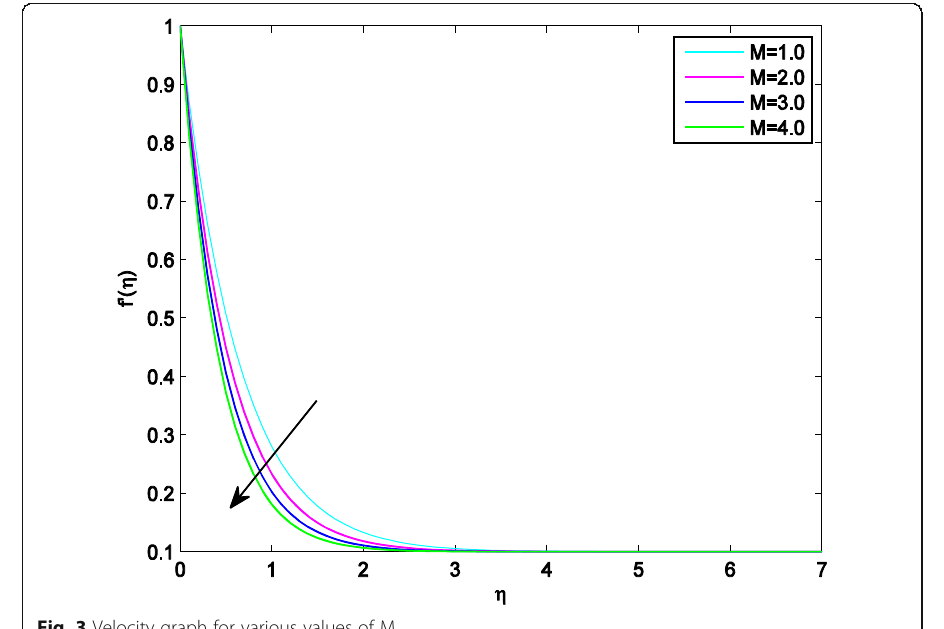
Fig. 3 Velocity graph for various values of M